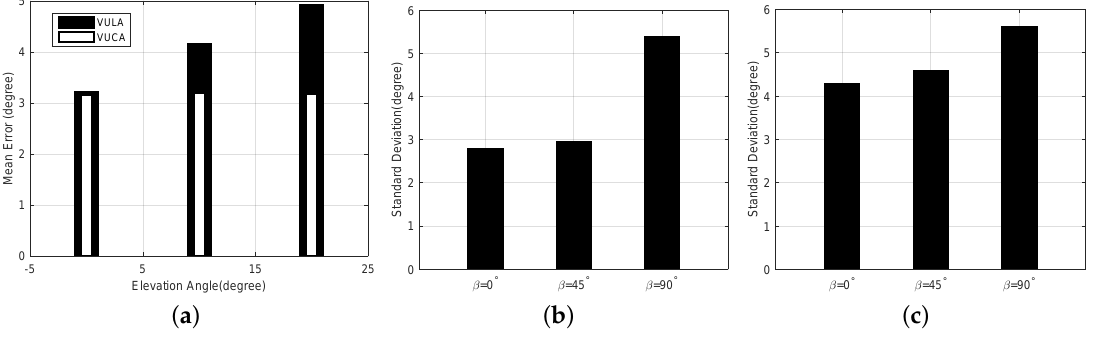
Figure 10. ( a ) mean error of VULA and VUCA when θ = 0 ◦ ;10 ◦ ;20 ◦ and L = 8 m; ( b ) standard deviations of angular error when L ≤ 6 m; and ( c ) standard deviations of angular error when L = 24 m.